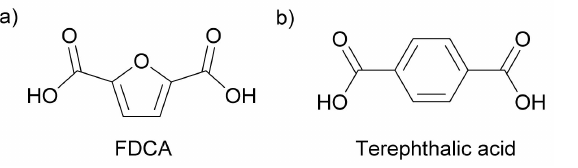
Figure 1. Chemical structures of ( a ) 2,5-furandicarboxylic acid and ( b ) terephthalic